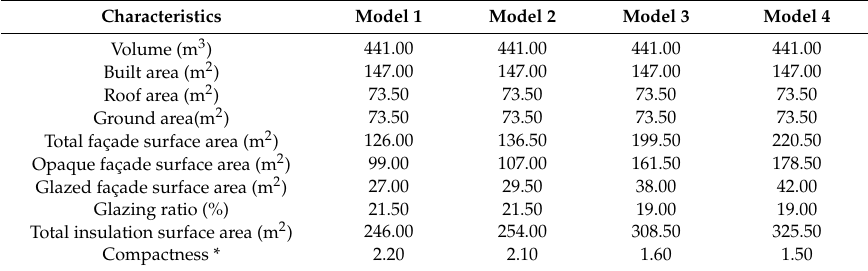
Figure 3. ( a ) Configuration of the Model 1; ( b ) Configuration of the Model 2; ( c ) Configuration of the Model 3; and, ( d ) Configuration of the Model 4. Table 3. Characteristics of the building for di ff erent models